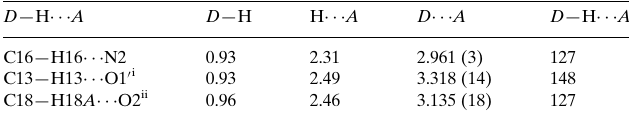
Hydrogen-bond geometry (A˚ , (cid:2)